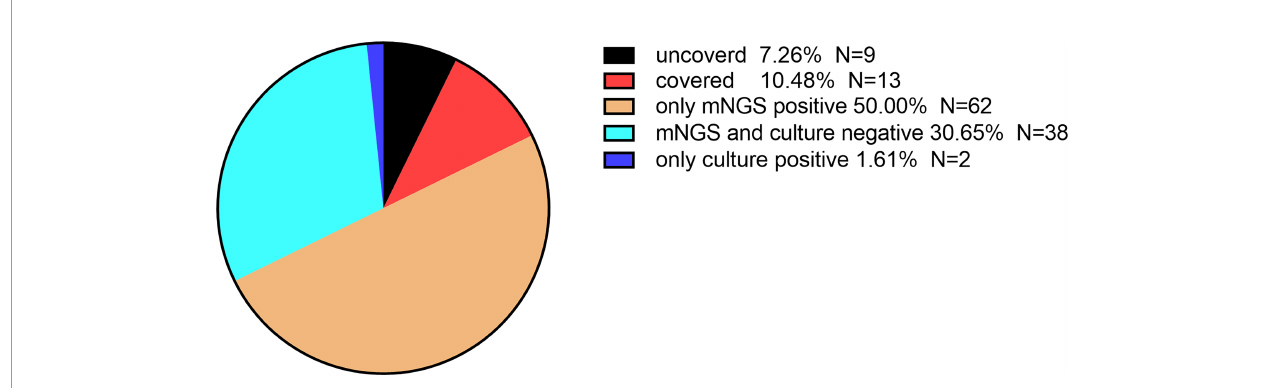
FIGURE 2 | Consistency analysis of mNGS and blood culture results. Patients, covered or uncovered, had positive mNGS and blood culture results